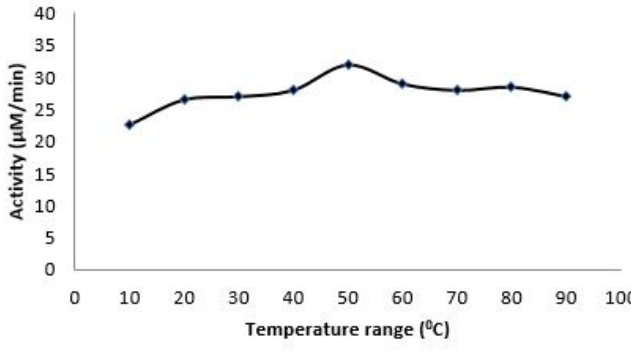
Figure 5: Effect of temperature on C. lanatus rind invertase activity.